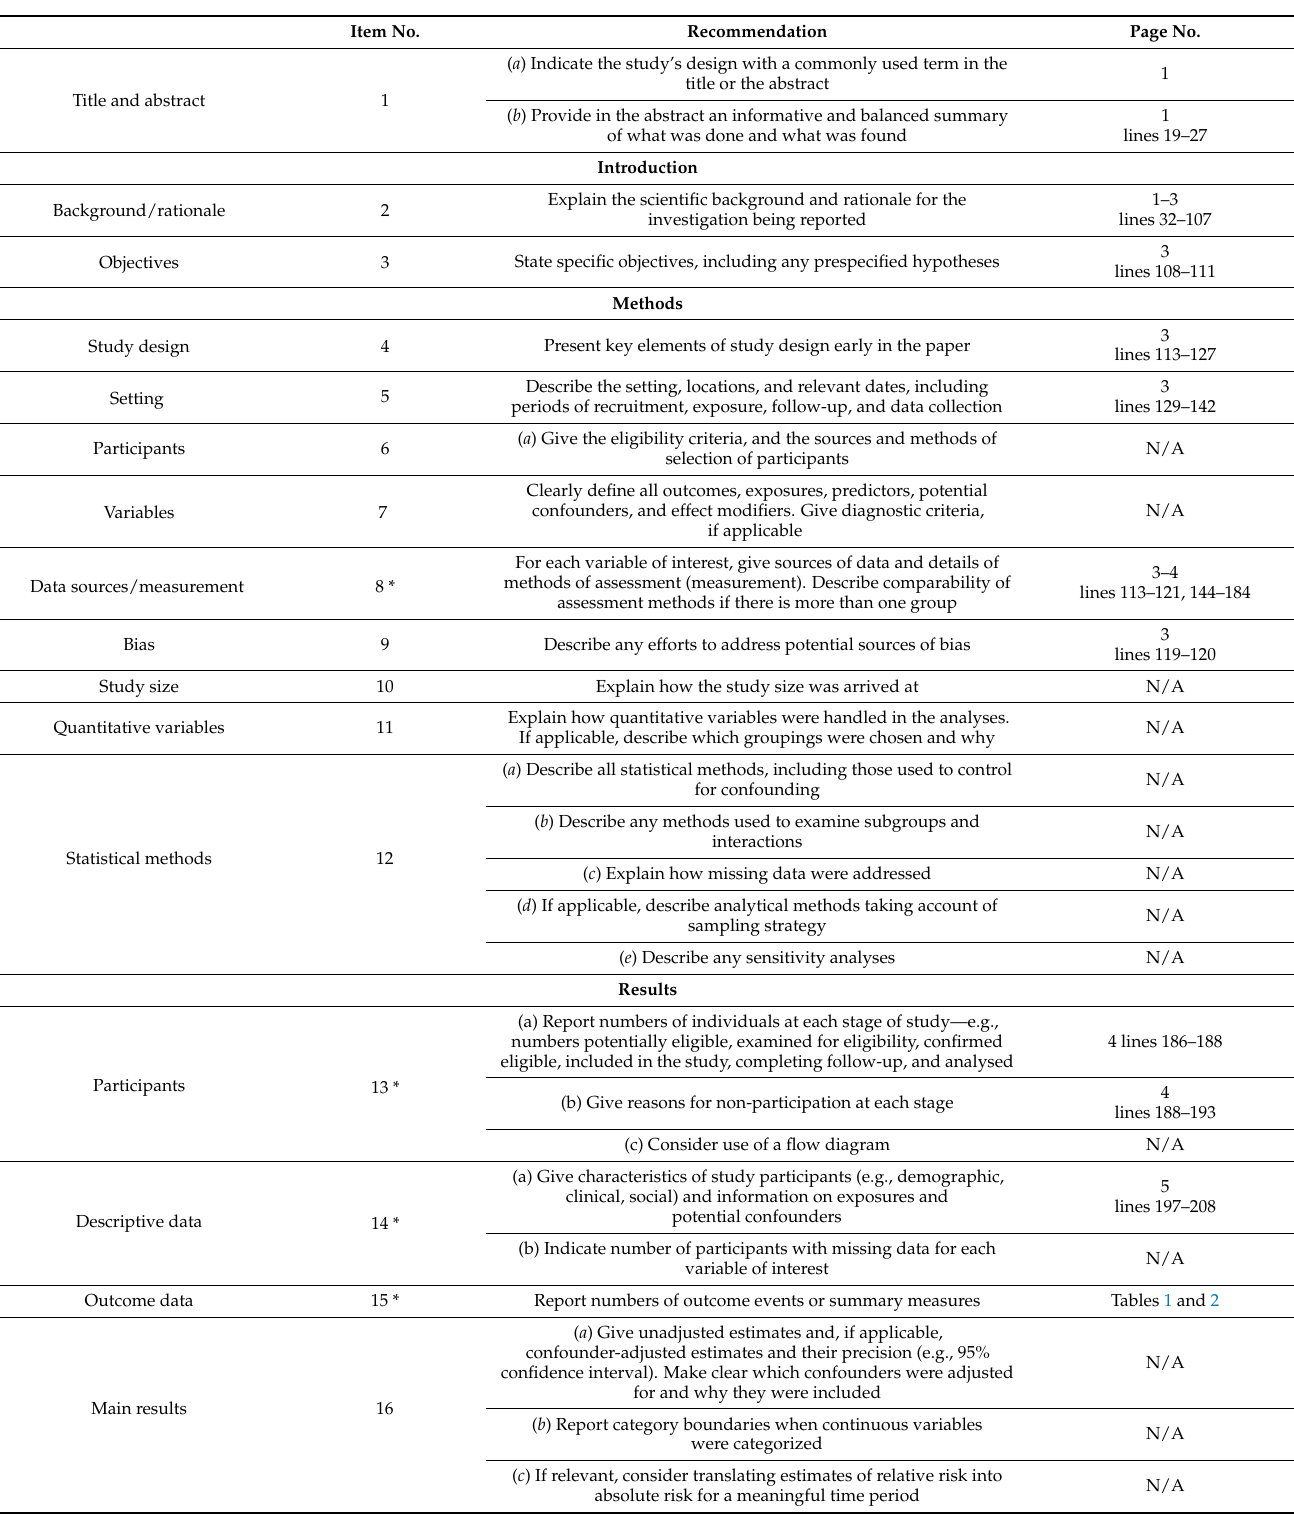
Table A1. STROBE Statement—Checklist of items that should be included in reports of cross- sectional